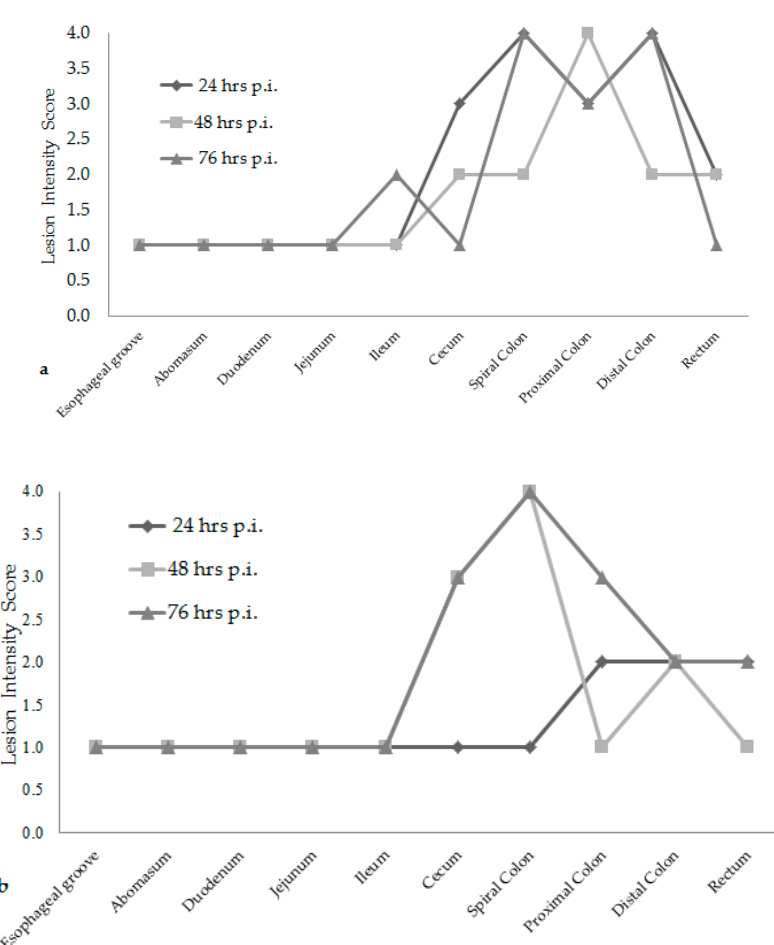
Figure 1. Overall lesion scores at each time increment for the wildlife E. coli O157:H7 inoculum group of calves ( a ). Overall lesion scores at each time increment for the bovine E. coli O157:H7 inoculum group of calves ( b ). (hrs) hours; (p.i.) post-inoculation. After ANOVA and post hoc testing, mean crypt lengths in the proximal colon were not significantly different ( p = 0.109) when each E. coli O157:H7 group was compared by time increments, but were significantly different ( p < 0.001) when compared within each E. coli O157:H7 inoculum group. The 24 h post-inoculation mean crypt lengths in the wildlife and bovine E. coli O157:H7 calves were both longer when compared to the calves euthanized at 48 h post-inoculation, who had mean lengths of 104.3 µ m and 90.1 µ m. All mean lengths were significantly longer when compared to the negative control mean, except for the calf inoculated with the bovine E. coli O157:H7 strain euthanized at 48 h post-inoculation. When comparing within E. coli O157:H7 inoculum groups for the distal colon, the calves inoculated with the wildlife strain had no significant differences ( p = 0.287) in mean lengths but the calf inoculated with the bovine strain euthanized at 24 h post-inoculation had significantly longer crypt lengths when compared to the calves inoculated with the bovine strain euthanized at 48 and 76 h post-inoculation ( p = 0.004, p < 0.001). There was also a significant difference in mean lengths at 48 and 76 h post-inoculation when each E. coli O157:H7 group was compared by time increments ( p = 0.037 and p = 0.004). For the distal colon, the negative control mean length was only significantly shorter when compared to the calf inoculated with the bovine strain euthanized at 24 h post-inoculation ( p < 0.001) and the calf inoculated with the wildlife strain euthanized 48 h post-inoculation ( p = 0.003), see Table 1.